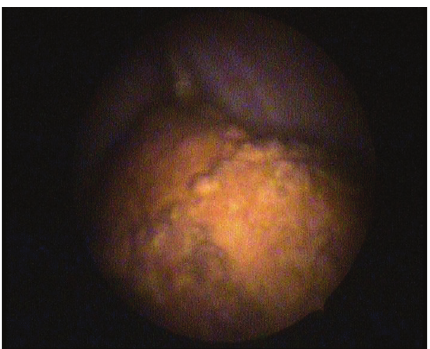
Figure 1: Transvaginal USG view of IUD.